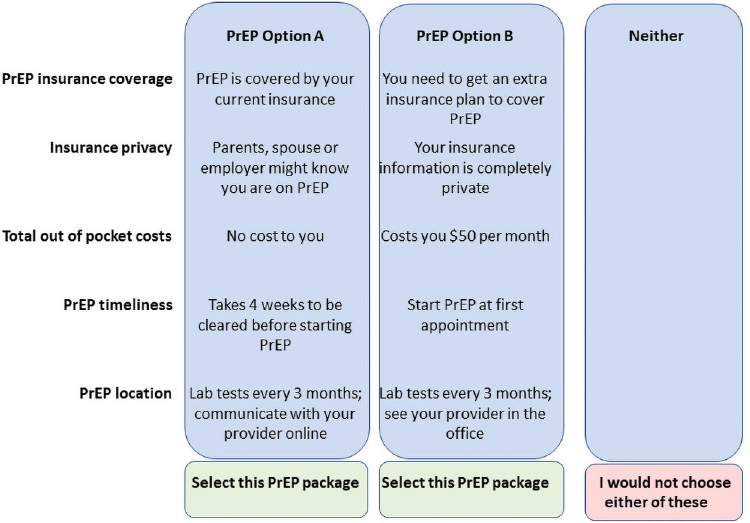
Fig 1. Example of a choice task related to PrEP access � . � This is one example only. Participants were shown a series of similar choice tasks with variation in the attributes presented; all possible attributes are listed in Table